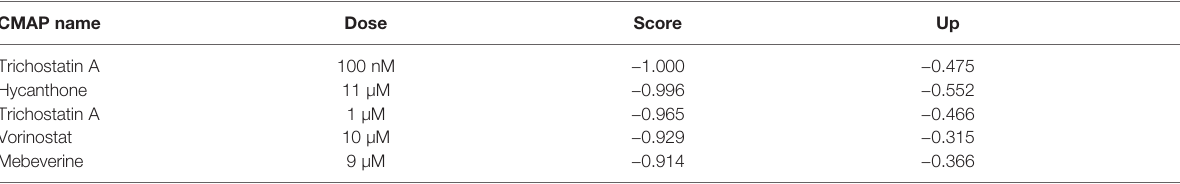
TABLE 2 | Four bioactive compounds identi fi ed as potential therapeutic agents for LUAD. CMAP